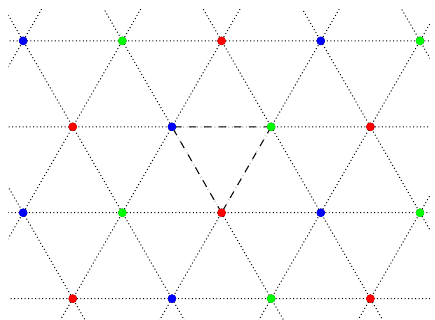
Figure 1: The triangular lattice. Qubits are placed on the vertices, which are colored in red, green and blue. The (cid:90) 3 symmetry is generated by spin flips on each of the 2 individual colors (which we label, the A,B,C sublattices). The pivot is an alternating sum of a three-body Ising interaction ZZZ over all